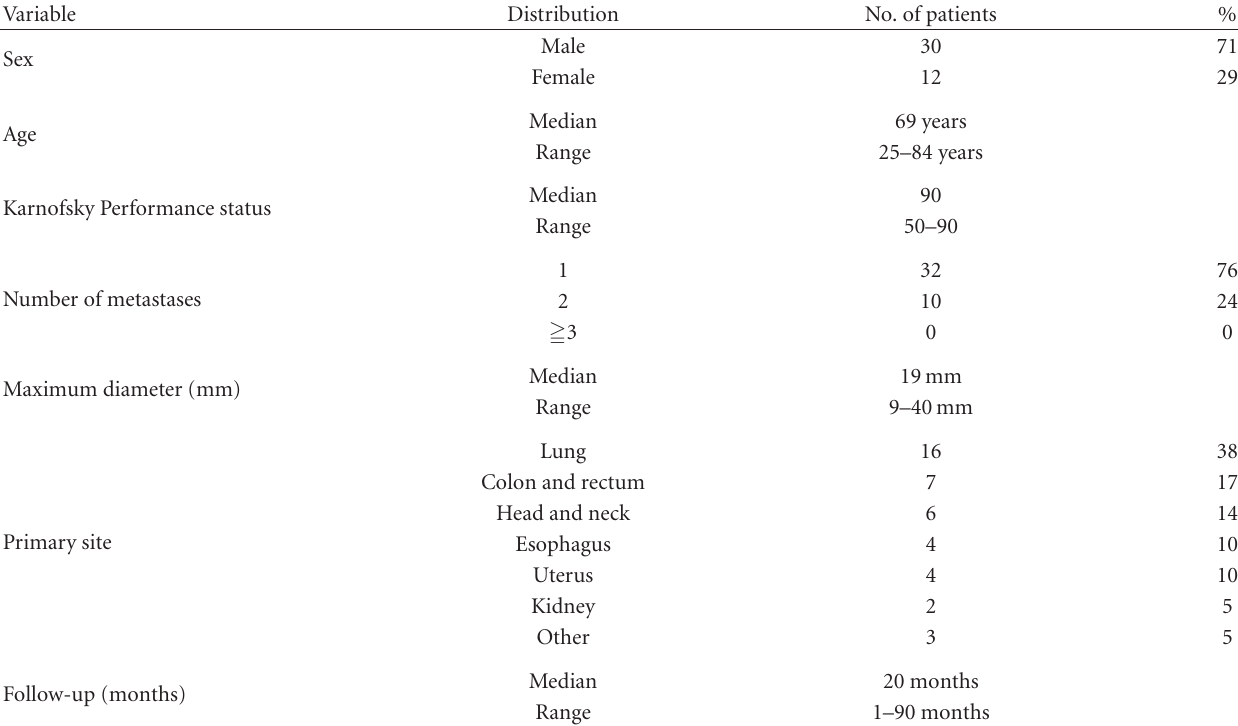
Table 1: Patients characteristics ( n =